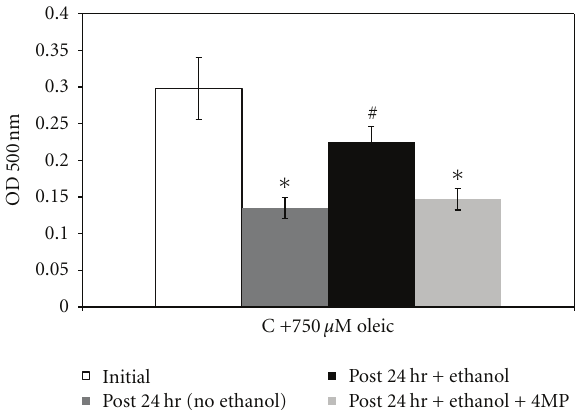
Figure 6: Fat e ffl ux from hepatic cells is impaired by ethanol treatment. WIF-B cell cultures were “loaded” with fat for 48 hours, washed, and then reintroduced into fresh media. Oil Red O staining was measured before and after a 24-hour “washout” period. Data are expressed as fat content pre- and post-washout as intensities of Oil Red O for quantification. Values are means ± SEM ( N = 4). ∗ Significantly di ff erent ( P < 0 . 05) from control (initial fat load) group. # Significantly di ff erent from all other groups.